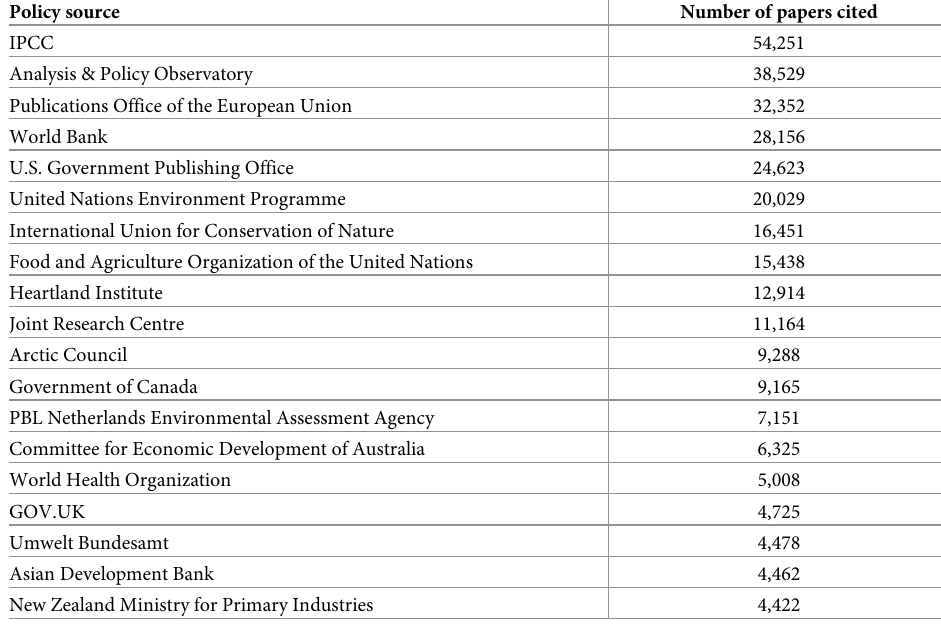
Table 2. Policy sources with the largest number of climate change papers cited. The table shows policy sources that cited more than 4.000 papers. Policy